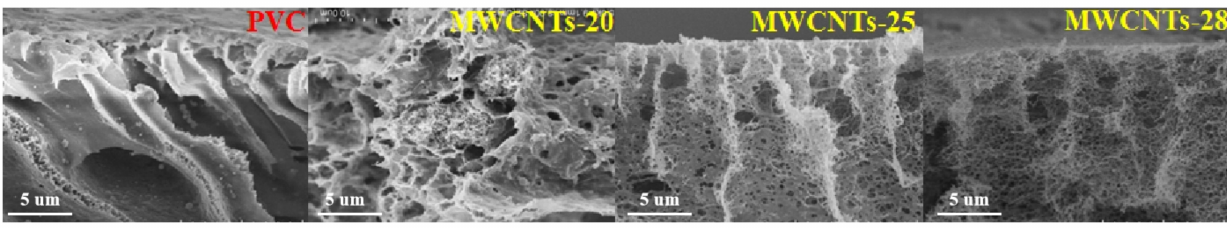
Figure 6. Cross-sectional SEM images of PVC, MWCNTs-20, MWCNTs-25, and MWCNTs-28 membranes.